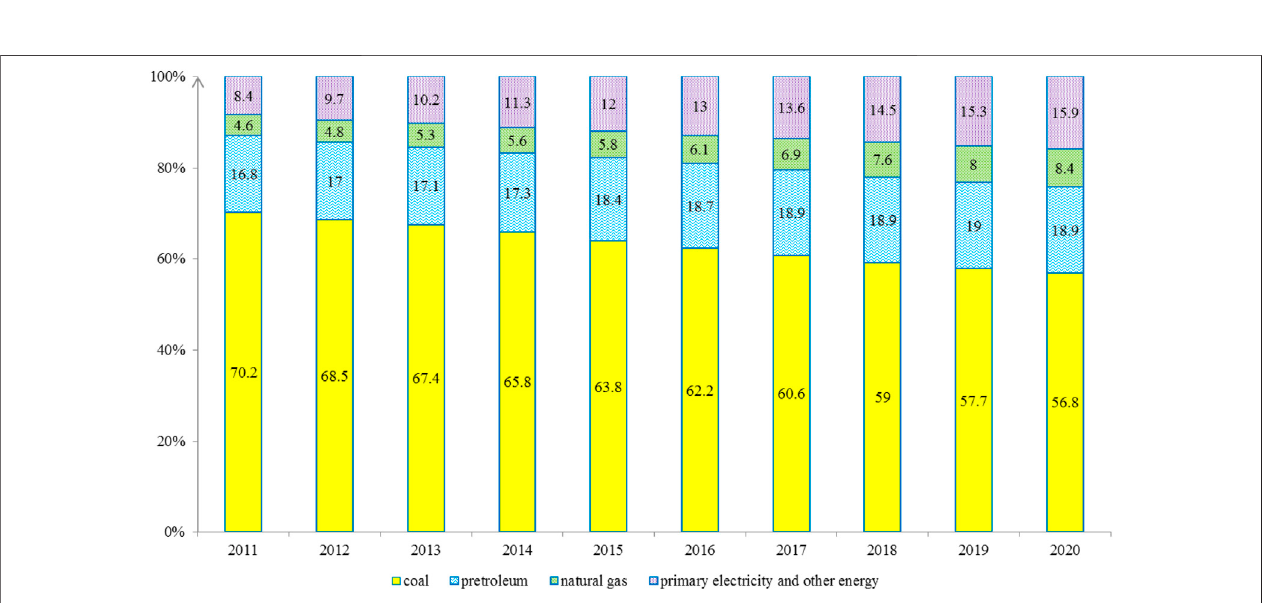
Frontiers in Environmental Science |